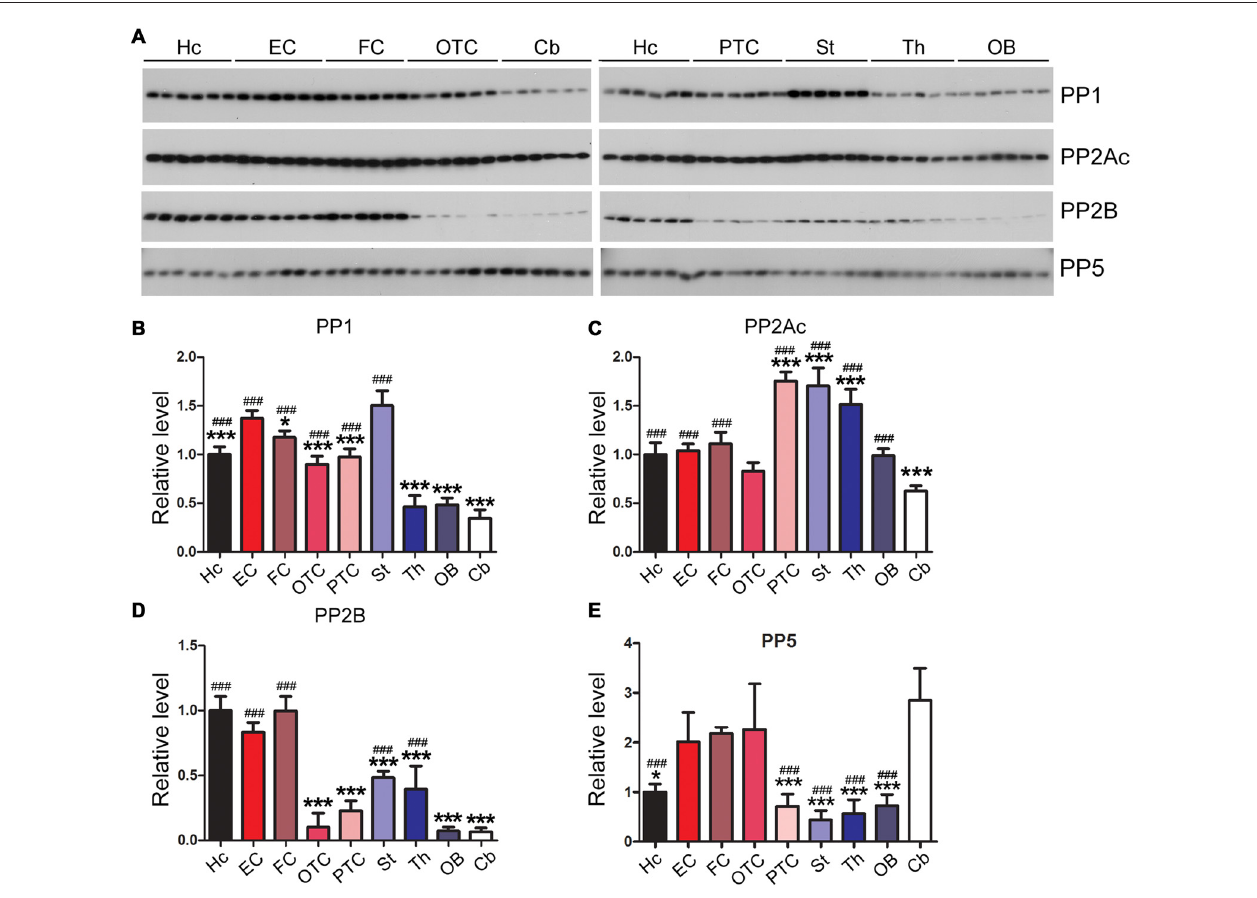
FIGURE 7 | Expression levels of tau phosphatases are different in different regions of the rat brain. Western blots (A) were used to analyze the levels of tau phosphatases, protein phosphatase 1 (PP1) (B) , catalytic subunit of protein phosphatase 2A (PP2Ac) (C) , protein phosphatase 2B (PP2B) (D) and protein phosphatase 5 (PP5) (E) . Data are expressed as mean ± SD, which represents matched observations of individual brain regions in six rats. ∗ Compared to EC; # compared to cerebellum. ∗ P < 0.05; ∗∗∗ , ### P <